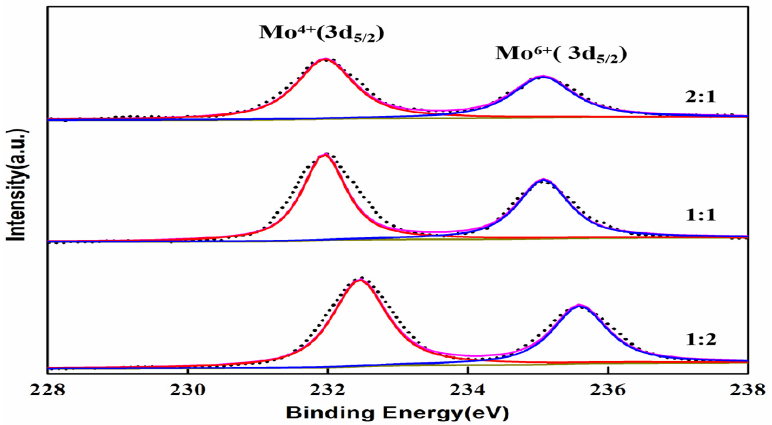
Figure 6. The deconvoluted peaks of Mo3d in Cu/MoO x samples.